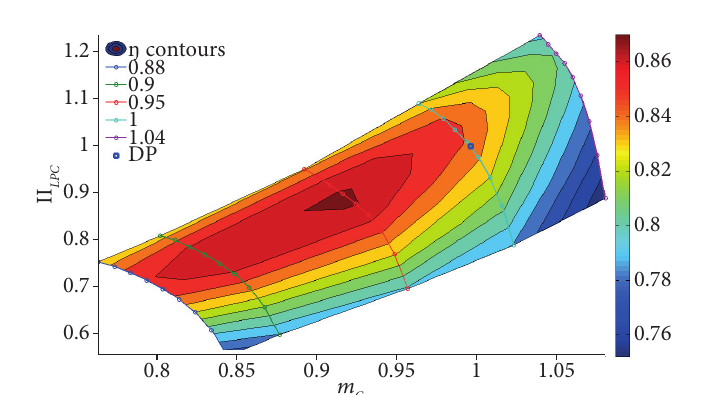
Figure 3. Original normalized HPC map.